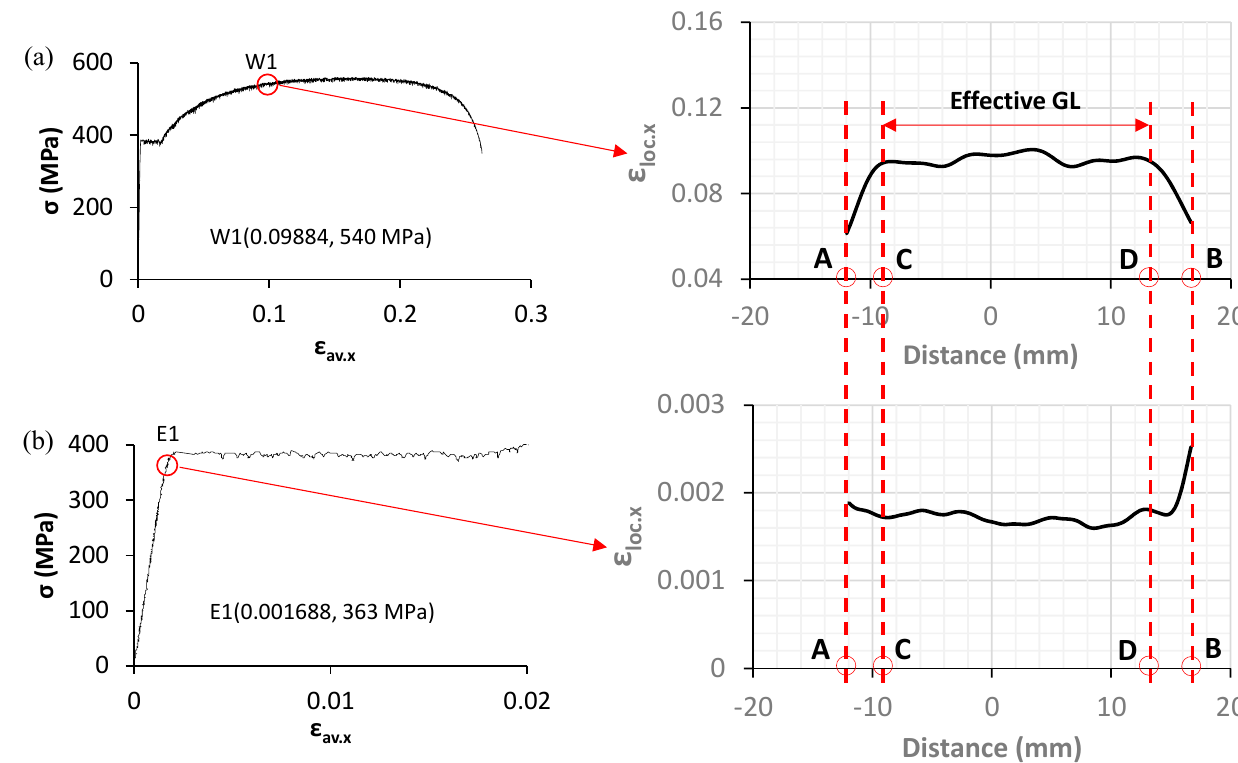
Figure 6. The longitudinal local strain ( ε loc.x ) distribution along the AB line shown in Figure 3a at ( a ) point W1 in Phase 3, and ( b ) point E1 in Phase 1. The effective gauge length (GL) (i.e., the length of the CD line) shown in Figure 3a is 22.9 mm.